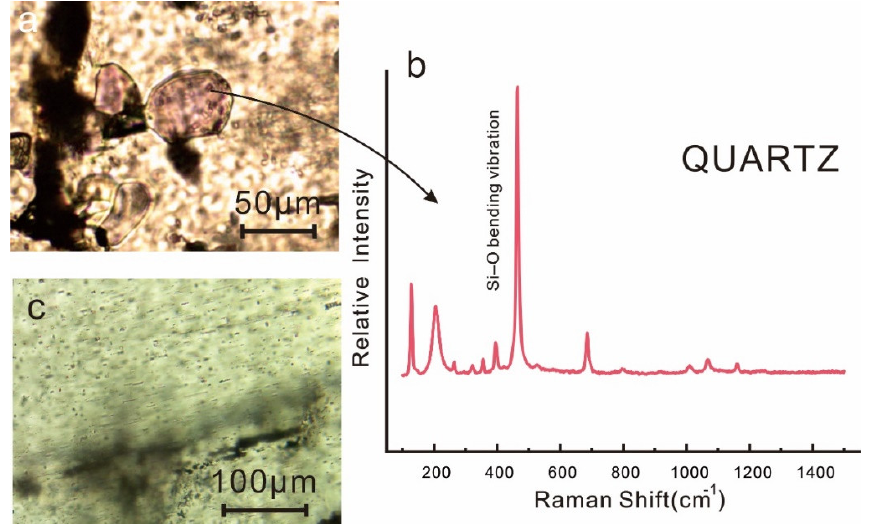
Figure 7. ( a ) Quartz inclusions and ( b ) their Raman spectrum. ( c ) Gas–liquid two-phase fluid inclusions parallel to the c -axis.